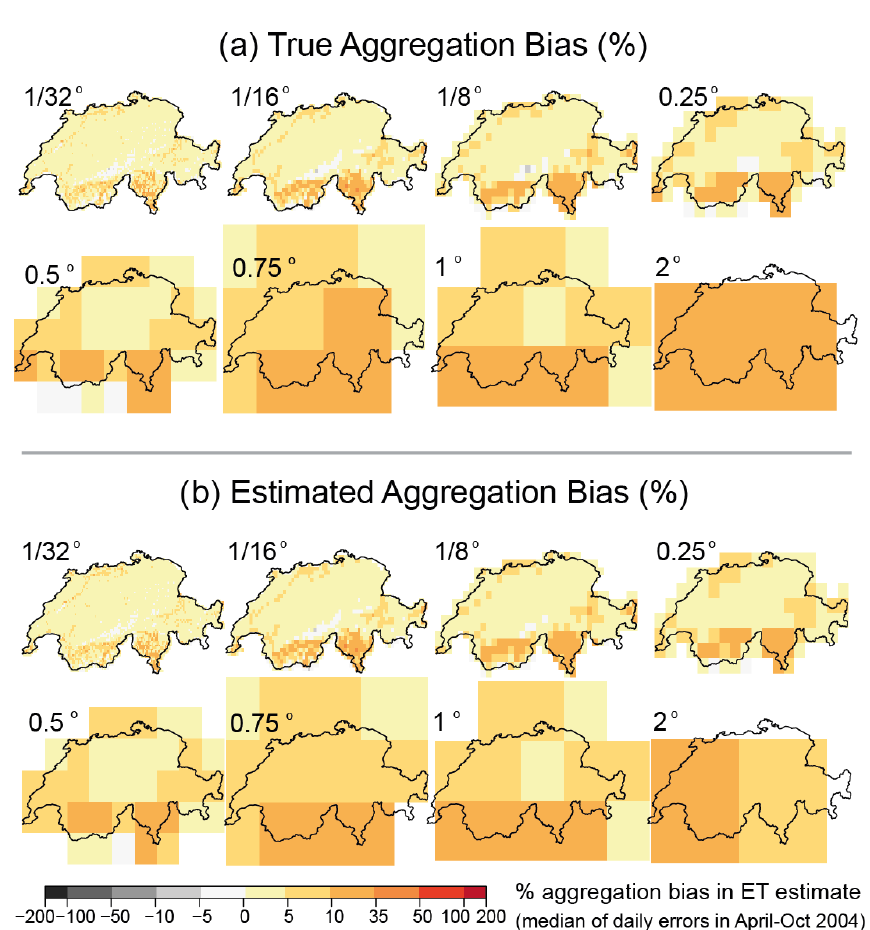
Figure 2. (a) True aggregation bias in ET, as calculated by averaging the 500m resolution ET estimates using fine-resolution input data in Eq. (6), over 1 / 32, 1 / 16, 1 / 8, 0.25, 0.5, 0.75, 1, and 2 ◦ grid cells across Switzerland. (b) Aggregation bias in ET, as estimated by Eq. (7) from grid-cell-averaged temperature ( ◦ C), soil moisture ( w w ), net radiation ( R n ), their variances at each grid scale, and the covariances of all pairs of variables using the 500m input data. At finer grid scales, the aggregation bias is more localized and smaller on average. Across Switzerland as a whole, the average aggregation bias becomes smaller as grid scales become finer but never disappears